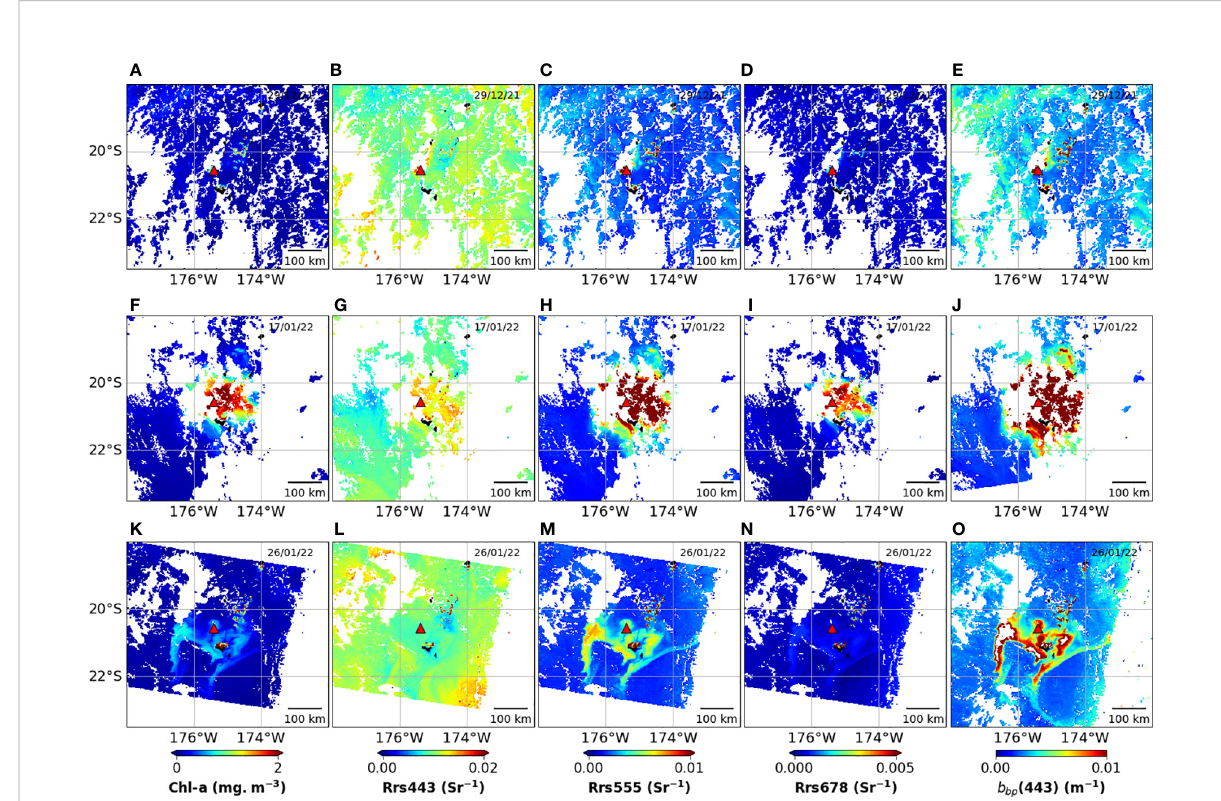
FIGURE 2 Comparison of MODIS and VIIRS extracted Chl-a, Rrs and Bbp products pre-eruption (A – E) on 29 December 2021, 2 days after the eruption (F – J) on 17 January 2022, and 9 days after the eruption (K – O) on 26 January 2022.